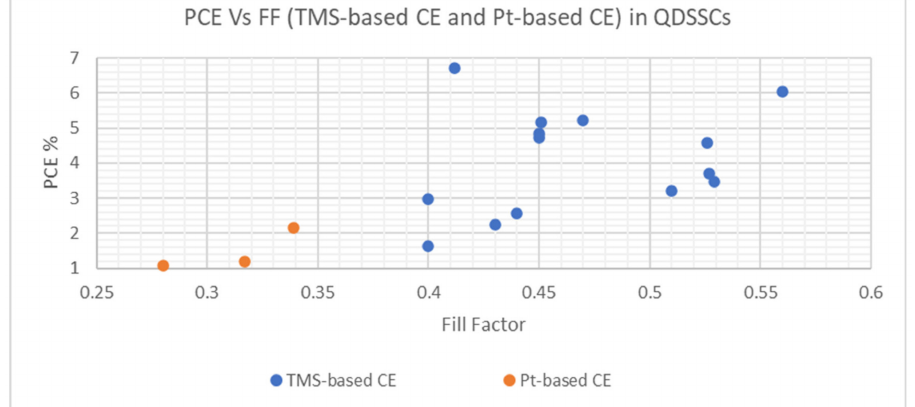
Figure 12. The PCE Vs FF performance for TMS-based CE and Pt-based CE in QDSSCs.